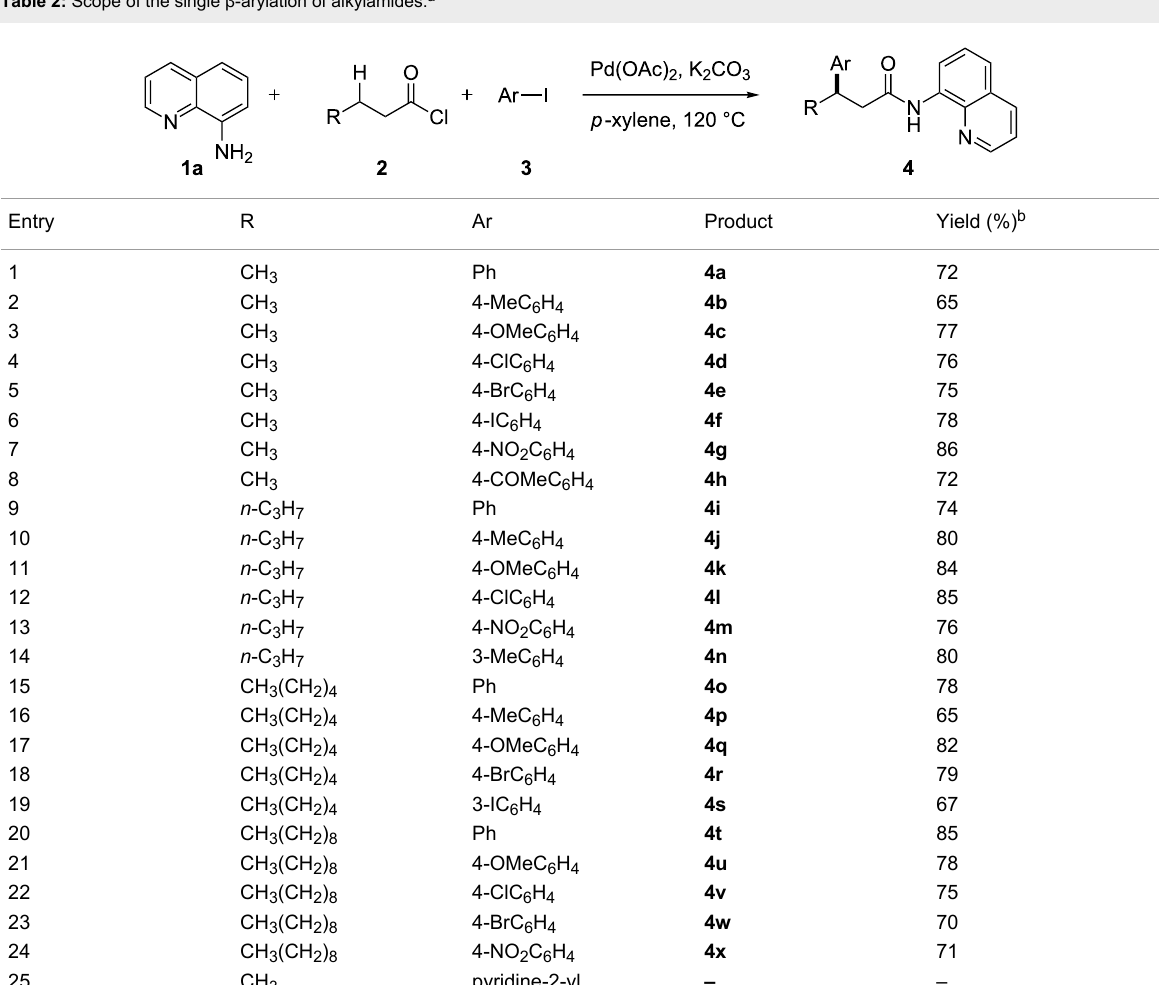
Table 2: Scope of the single β -arylation of alkylamides.